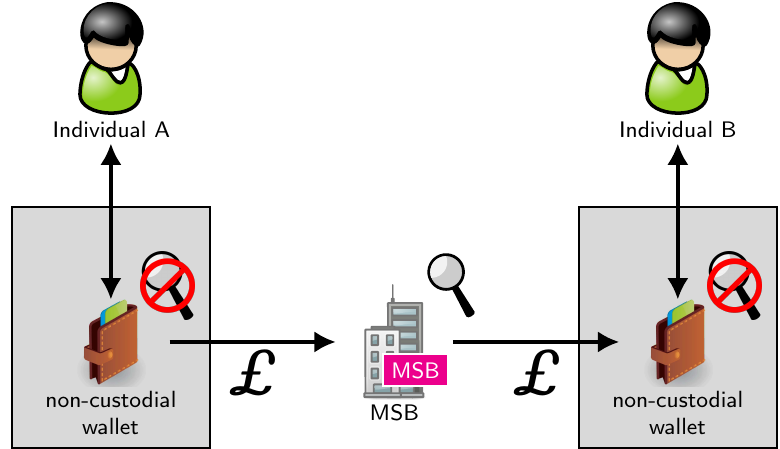
Figure 5. Schematic representation of a mediated transaction between